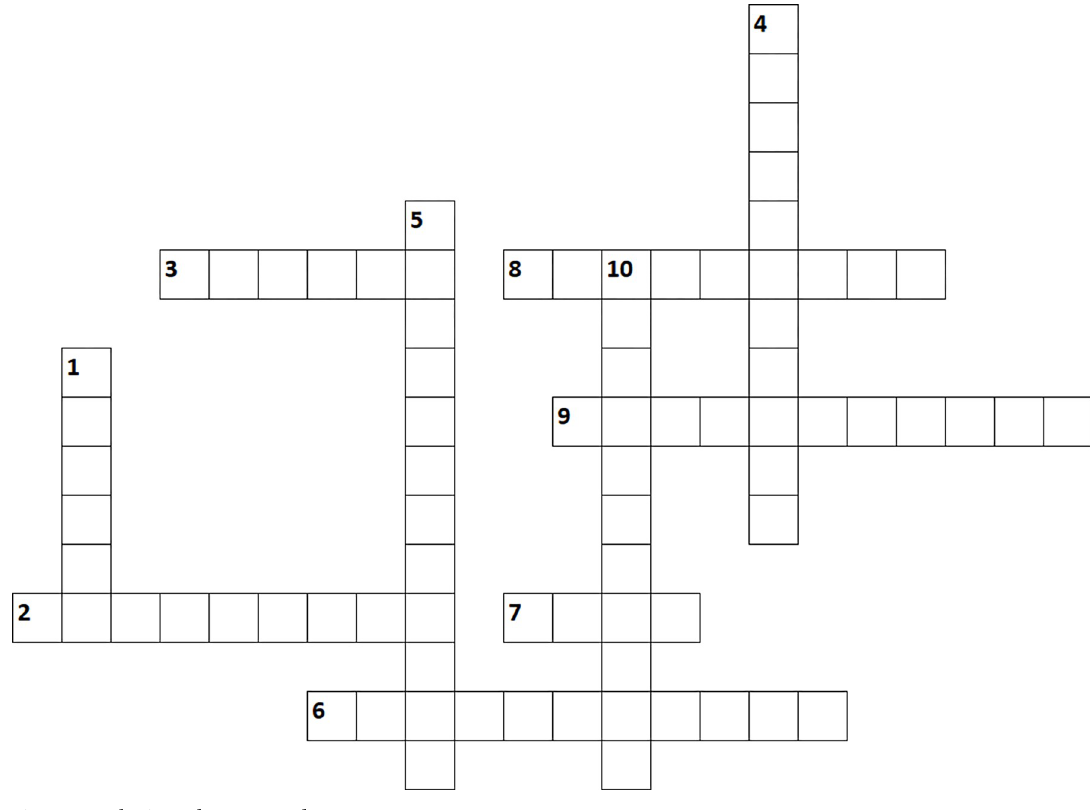
Fig 2. Data-sharing rules